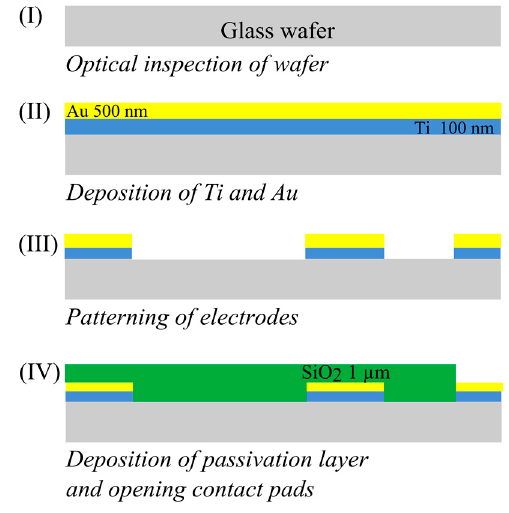
Figure 3. Schematic of the sensor fabrication process.